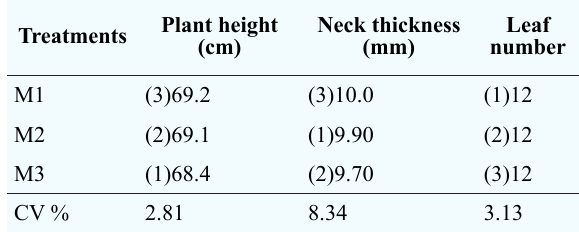
Table 3. Effect of fertilisation methods on the garlic